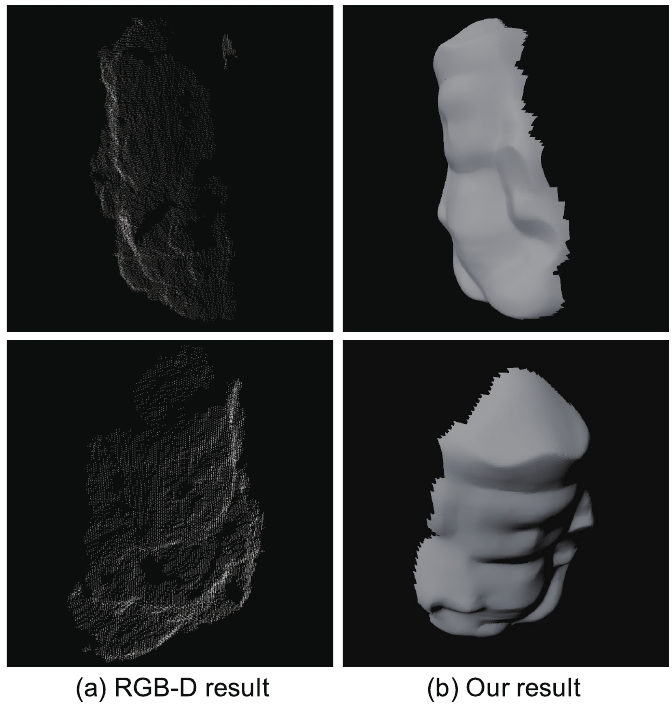
Figure 31. Comparison with off-the-shelf depth sensor: ( a ) Result of off-the-shelf depth sensor and ( b ) result of our method. The depth sensor can estimate the 3D coordinate of vertices successfully and the photometric stereo can estimate the surface normal